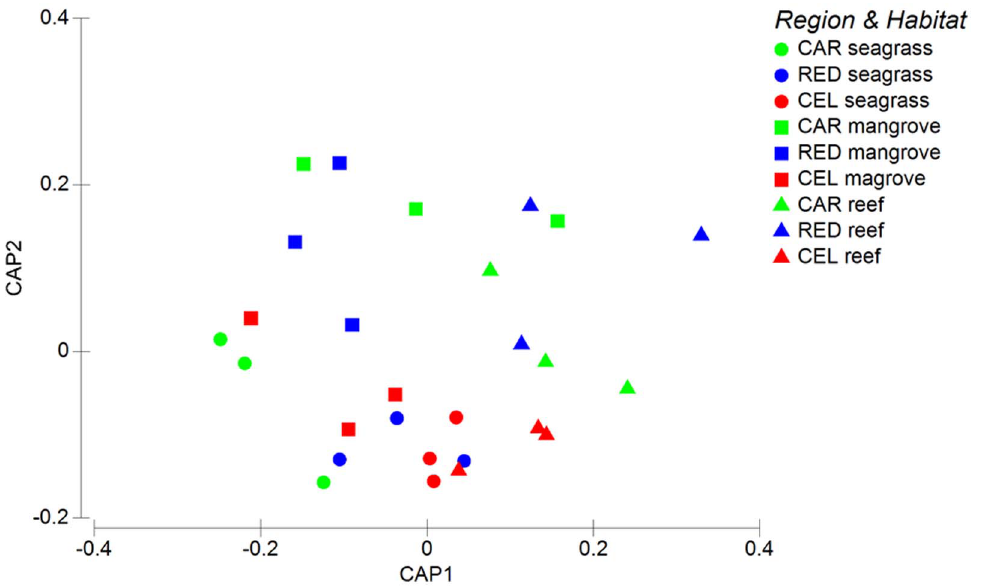
Figure 5. Bi-plots after the canonical analysis of principal coordinates illustrating differences in the composition of total meiofaunal taxa in the sediments of the investigated oceanic regions and habitats. CAR=Caribbean Sea (green); CEL=Celebes Sea (red); RED=Red Sea (blue).